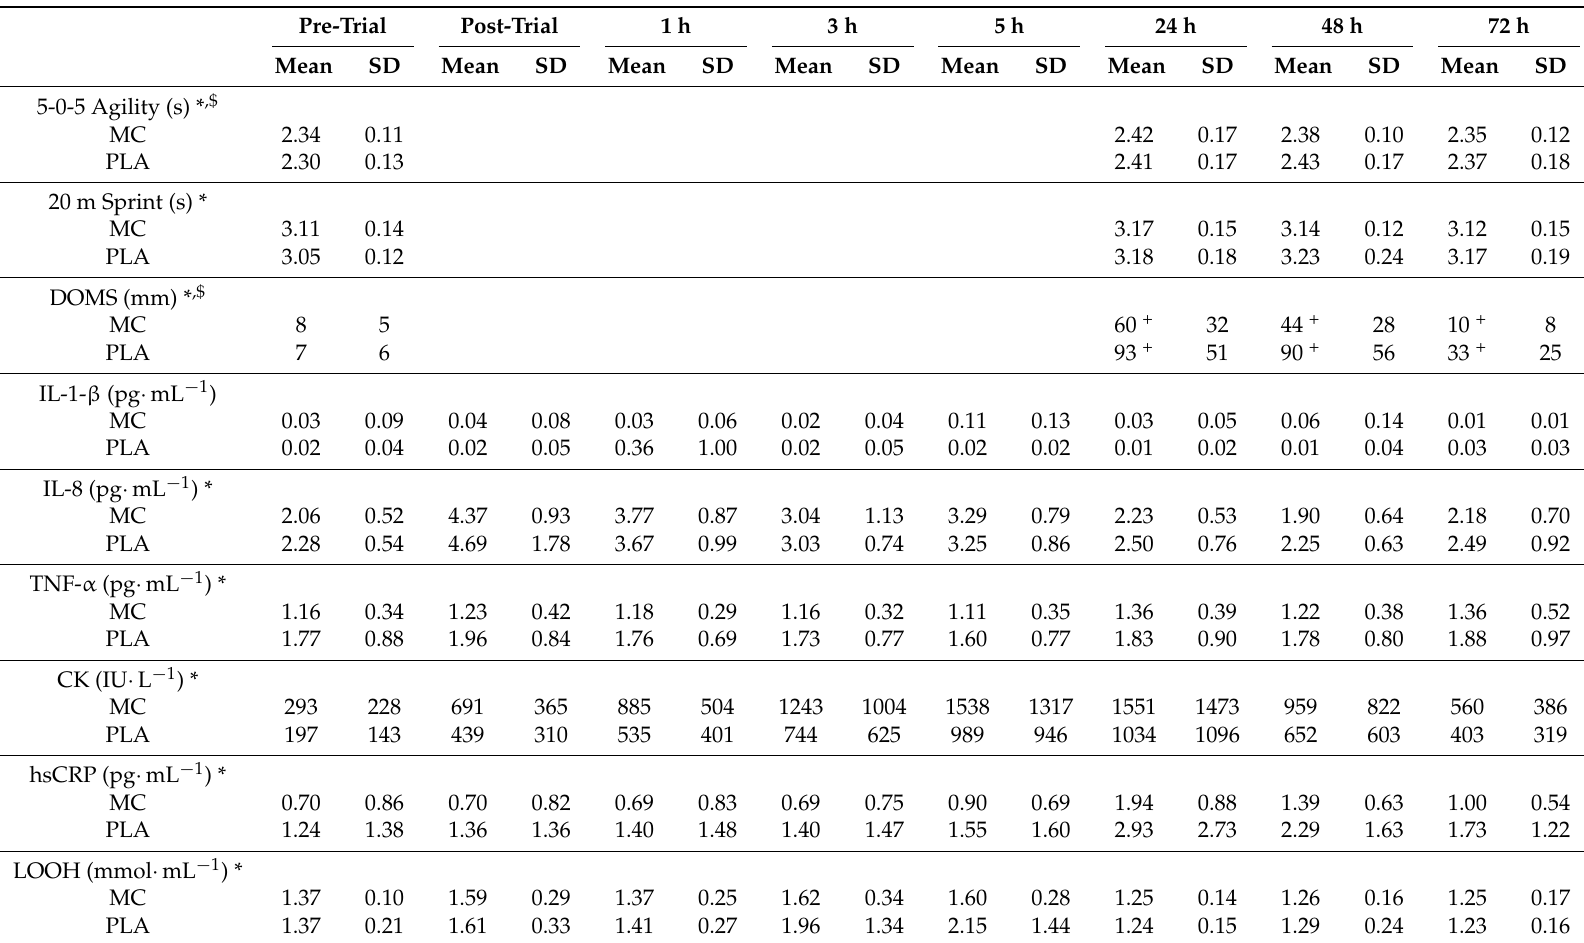
Table 1. Summary of other performance, inflammatory and oxidative stress